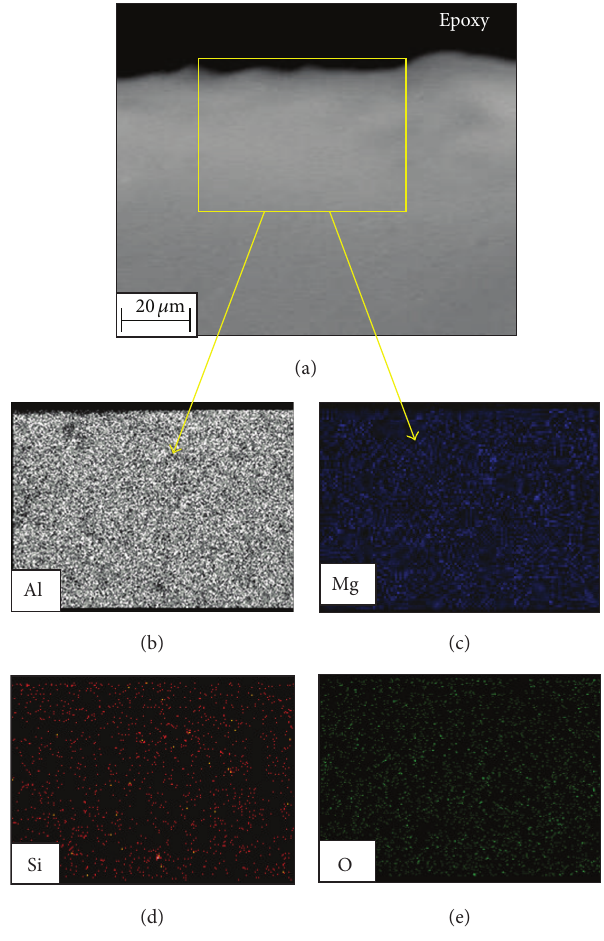
Figure 6: A cross-sectional image of nonoxidized fused metal part of welded AA6061 Al alloy, (a) SEM image, and EDS maps analyses of (b) Al, (c) Mg, (d) Si, and (e)